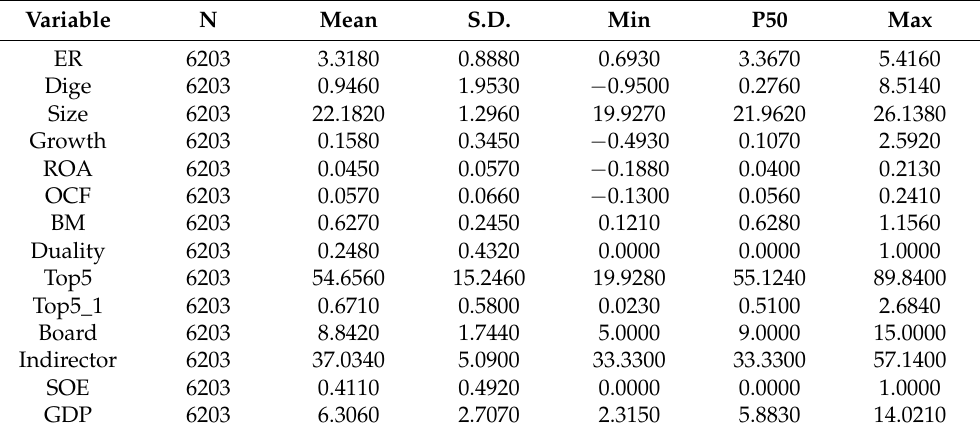
Table 2. Descriptive